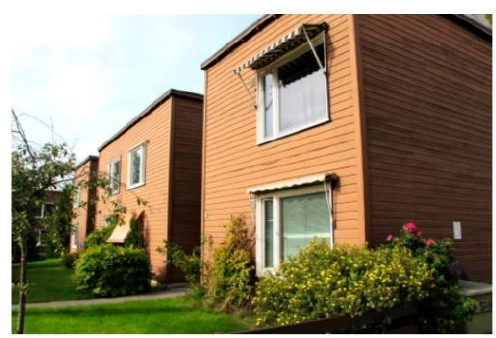
Figure 1. Haugerudsenteret.